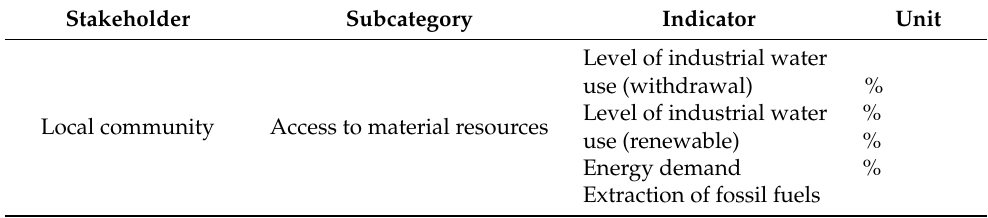
Table 11. Social indicators used to evaluate the social impact of pretreatment